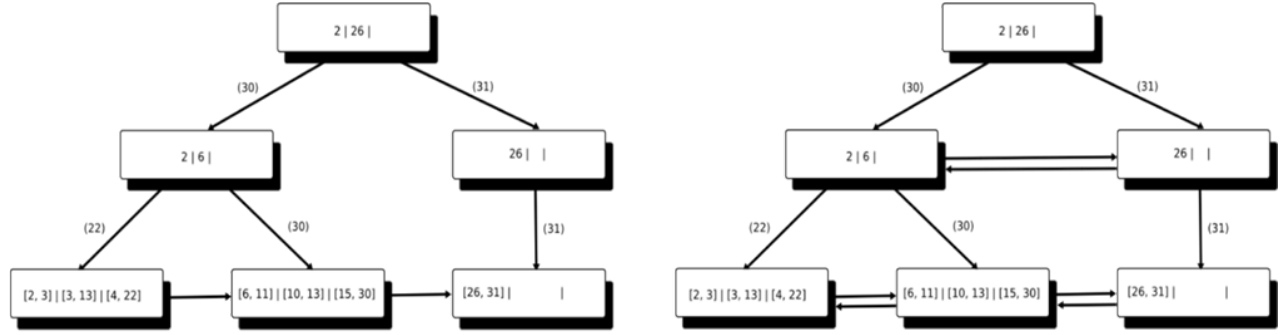
Figure 1. Structural differences between the IB+ tree (left) and the I2B+ tree (right), while indexing the same